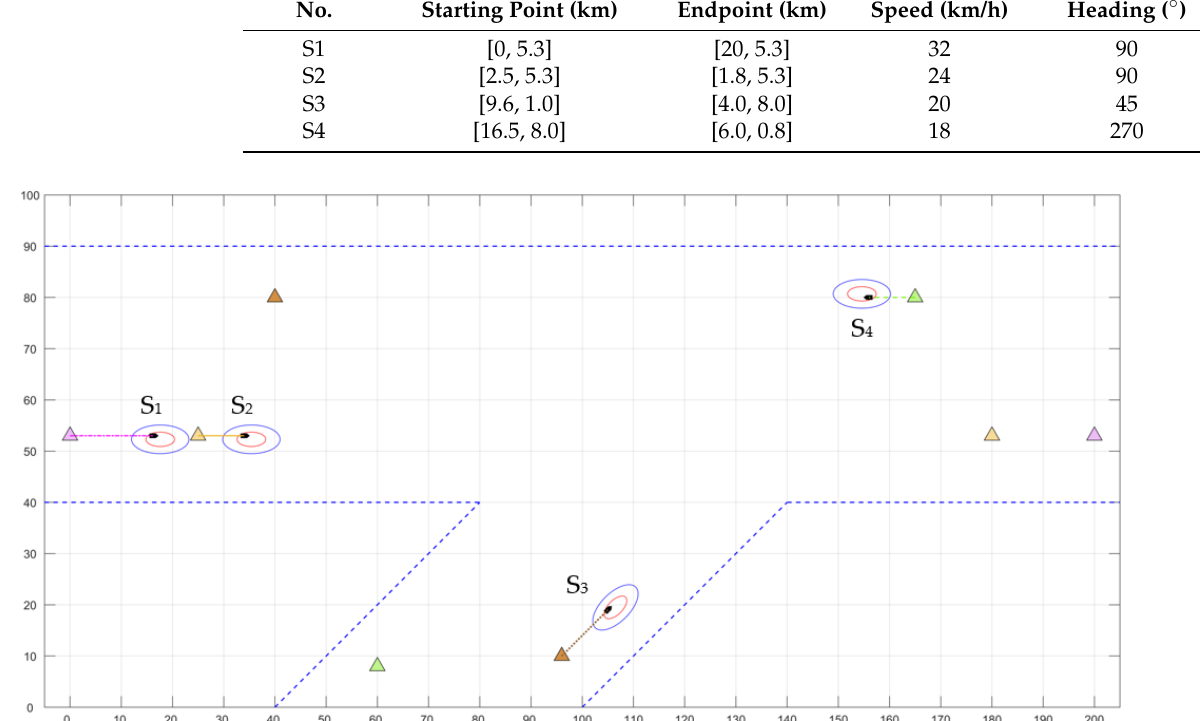
Figure 15. Verification of collision avoidance in a multi-ship situation.